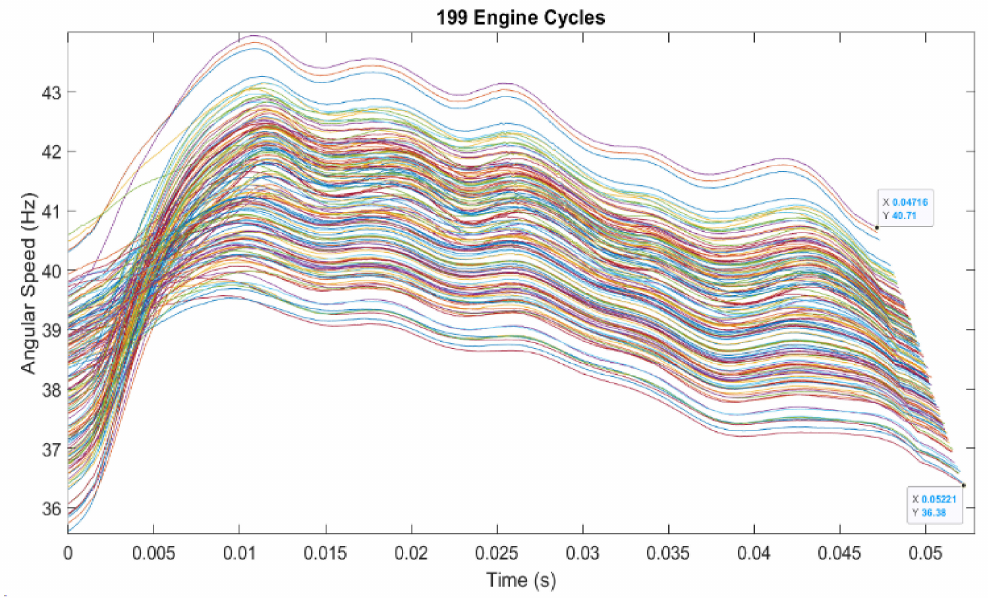
Figure 21. The engine in operation—199 visibly unique